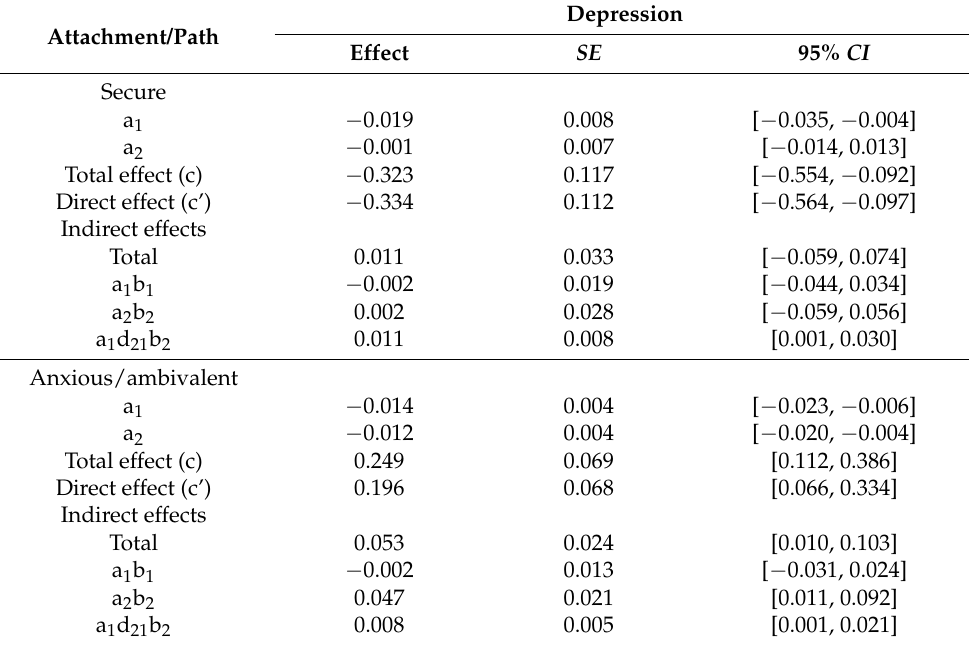
Table 3. Serial mediation analyses: Total, direct, and indirect effects of each pattern of attachment on depression, and intermediate